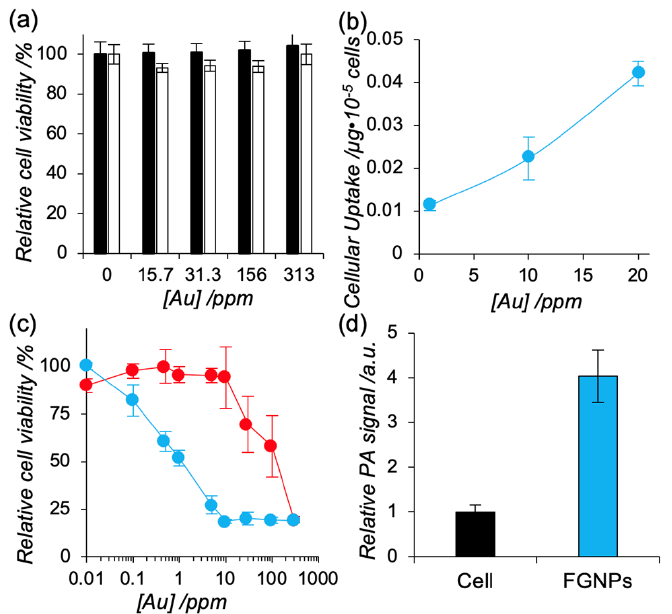
Figure 3. ( a ) Cytotoxicity of FGNPs against murine fibroblast (L929, black) and murine colon carcinoma (Colon26, white). The cells were co-incubated with FGNPs with varying concentration for 24 h. Cell viability of the treated cells were quantified with Cell Counting Kit-8 ( n = 3). Data represent mean ± SD. ( b ) Cellular uptake amount of FGNPs toward Colon26. Colon26 cells were exposed to FGNPs with varying concentration of FGNPs for 24 h. Concentration of gold within cells was quantified by ICP-AES ( n = 3). Data represent mean ± SD. ( c ) Photo-induced cytotoxicity toward Colon26 cells using FGNPs (blue) and GNPs (red). The cells were co-incubated with FGNPs with varying concentration for 24 h. The cells were exposed to light with optimal wavelength (>620 nm) for 30 mins. After 24 h incubation, the cell viability was confirmed by Cell Counting Kit-8 ( n = 3). Data represent mean ± SD. ( d ) Photoacoustic signal from Colon26 cells treated with FGNPs (blue). Colon26 cells were treated with FGNPs (20 ppm, blue) or MilliQ (nontreatment control, black) for 24 h and the collected cells were excited at 680 nm ( n = 3). Data represent mean ± SD. The accumulation of FGNPs in tumor tissue was visualized by PAI. Compared to the PBS injected group as the nontreated control, stronger PA signals were detected in tumor tissue in FGNPs treated group (Figure 4b,c), and the PA signals from FGNPs gradually